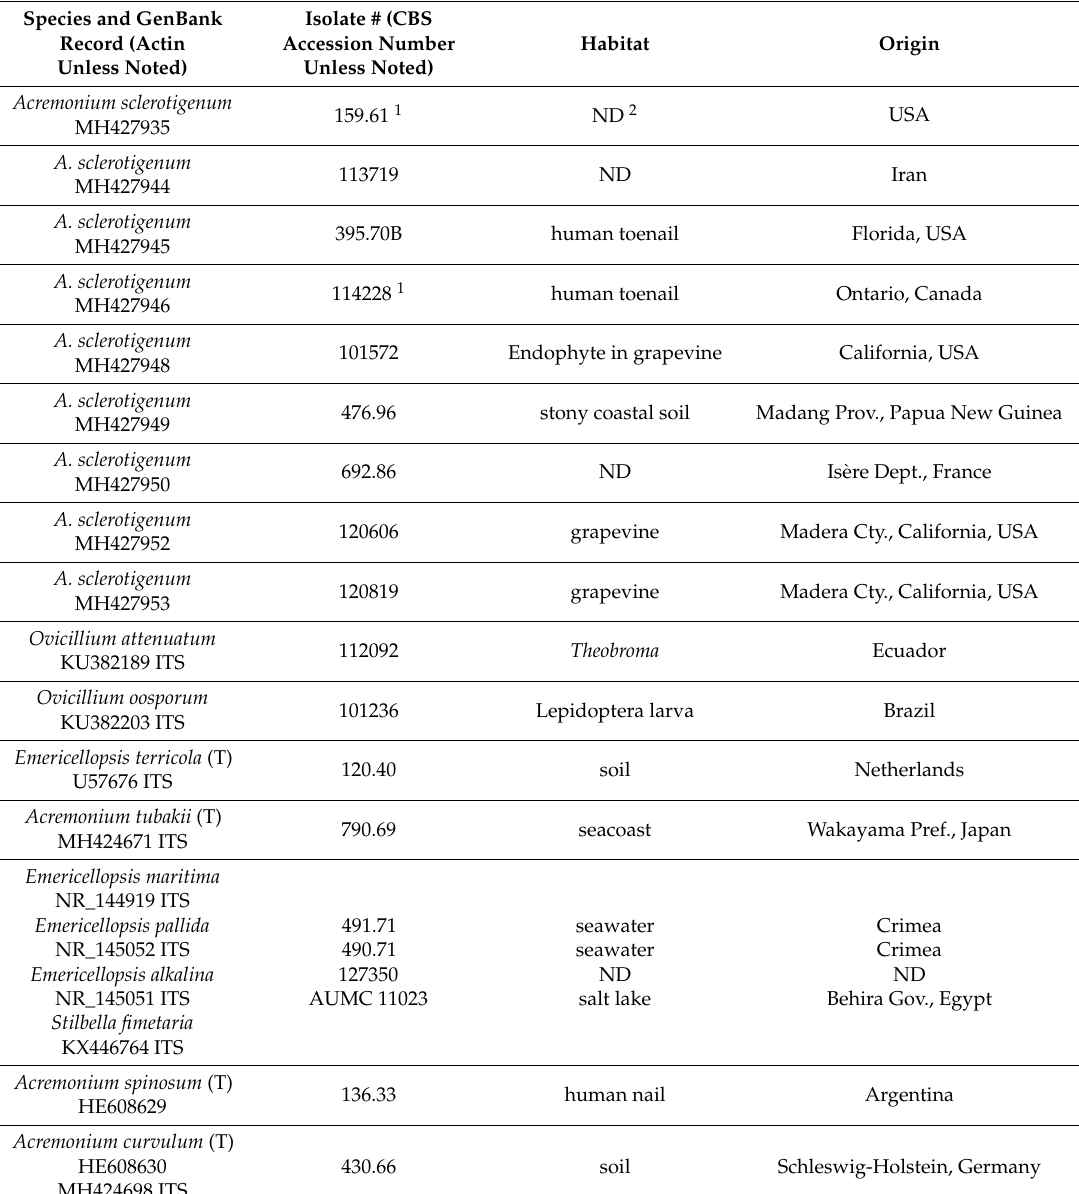
Table 3. Additional isolates included in actin sequencing only or as